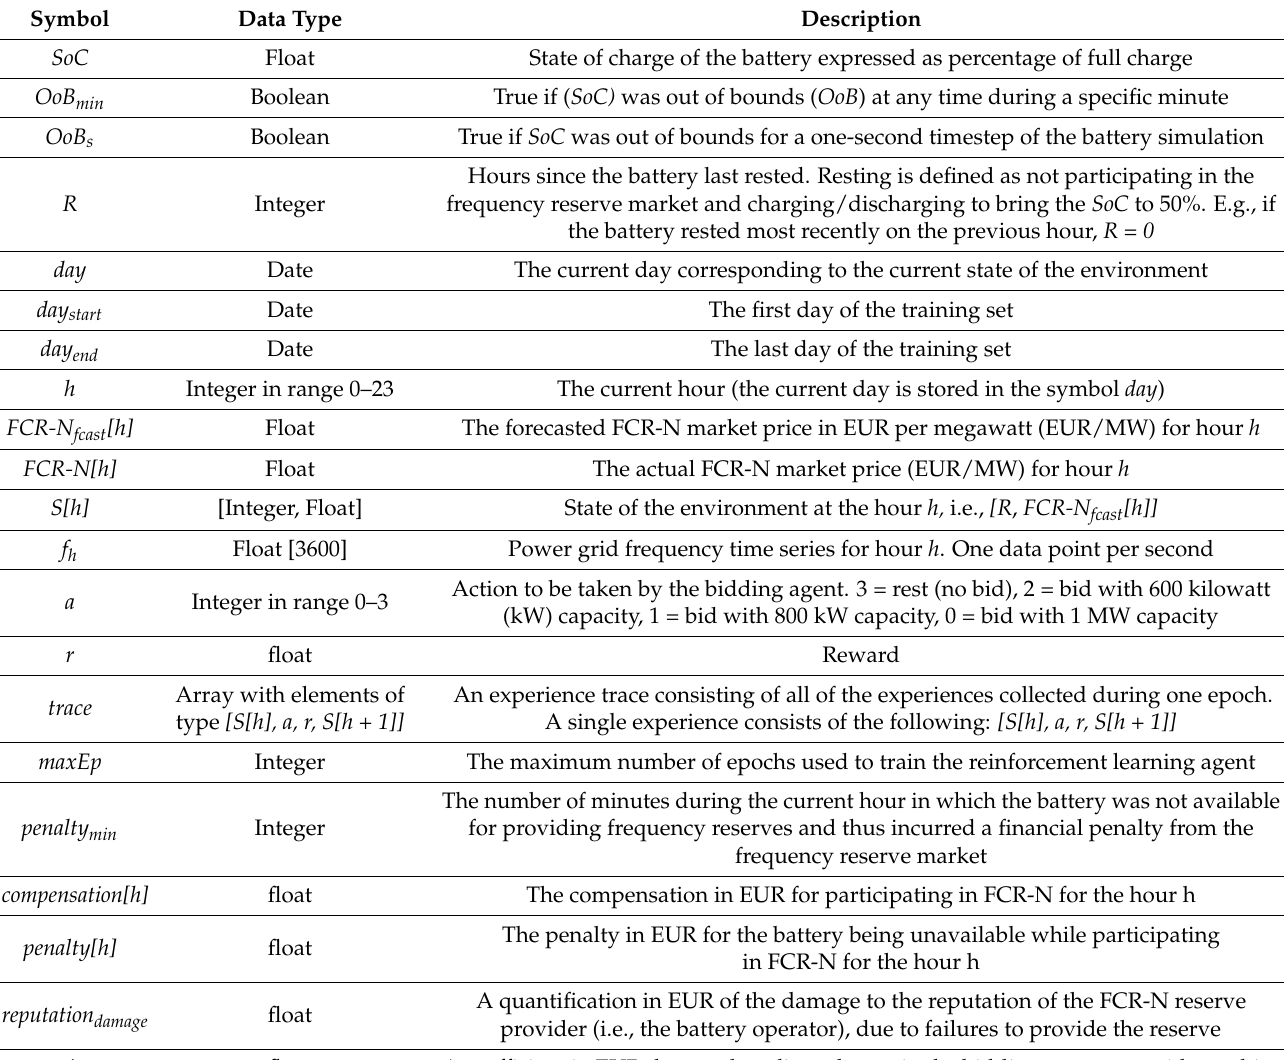
Figure 2. Setup for training the bidding agent. Table 1.